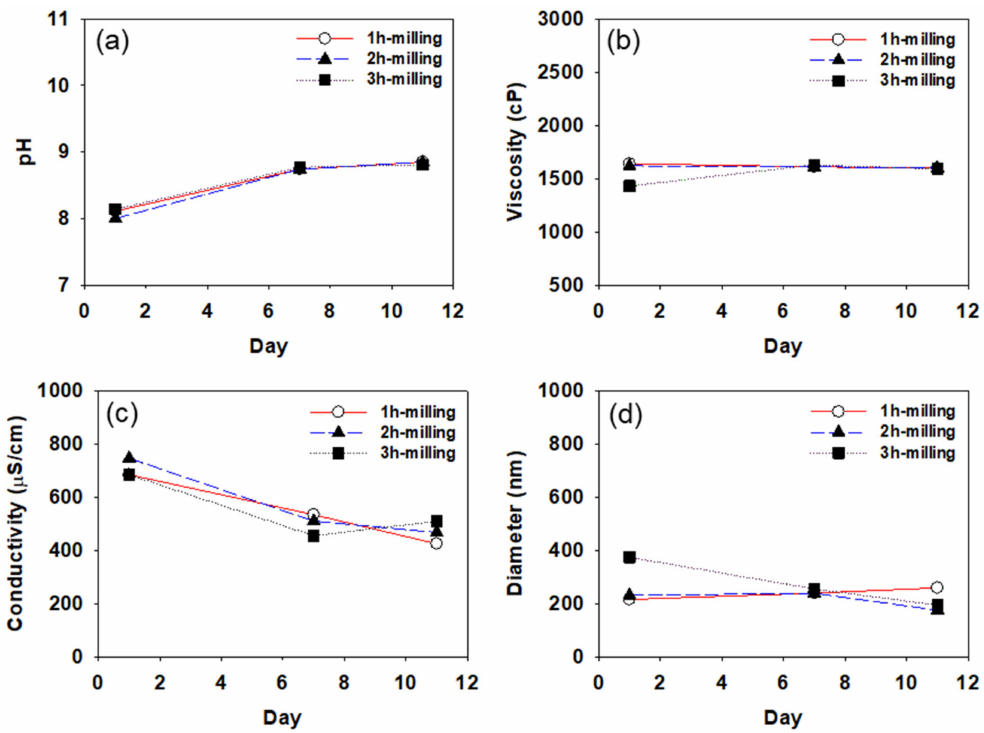
Figure 5. Variation of pH ( a ), viscosity ( b ), conductivity ( c ), and particle diameter ( d ) with time measured for the CB dispersions prepared using